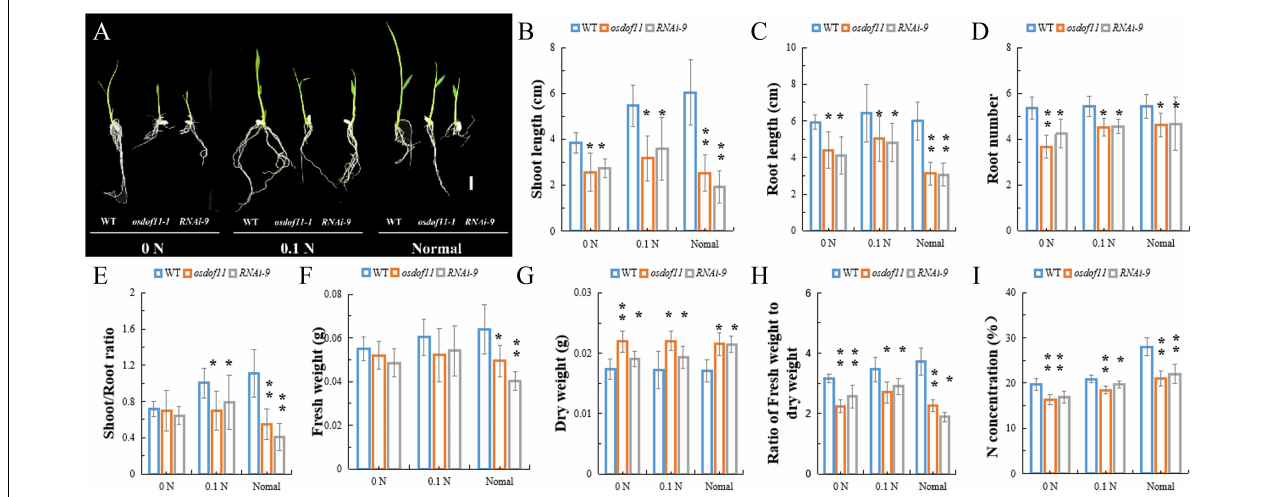
FIGURE 1 | Characterization of the OsDOF11 mutants at the seedling stage under multiple N contents in Yoshida medium. (A–H) Phenotypes of the odof11-1 mutant, OsDOF11-RNAi plants, and WT under multiple N concentrations of Yoshida medium. (A) Picture of seedling plants at 7 days after germination; (B) shoot length; (C) root length; (D) root number; (E) ratio of shoot to root length; (F) fresh weight; (G) dry weight, (H) ratio of fresh weight to dry weight; (I) N concentration. 0 N: Yoshida medium without nitrogen, 0.1 N: Yoshida medium with 10% nitrogen, and normal medium: Yoshida medium with a normal content of nitrogen. Scale bar = 1 cm. Error bars represent SE of at least five samples. * P < 0.05; ** P <